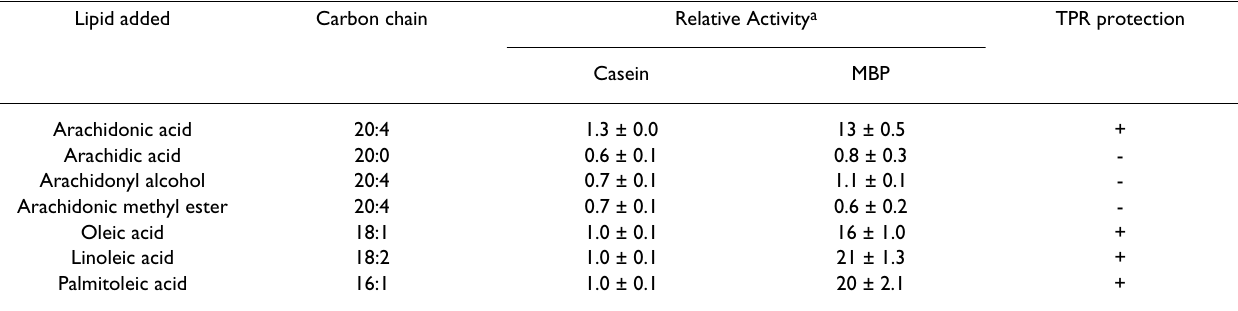
Table 1: Effect of various fatty acids on recombinant Ppt1p activity Lipid